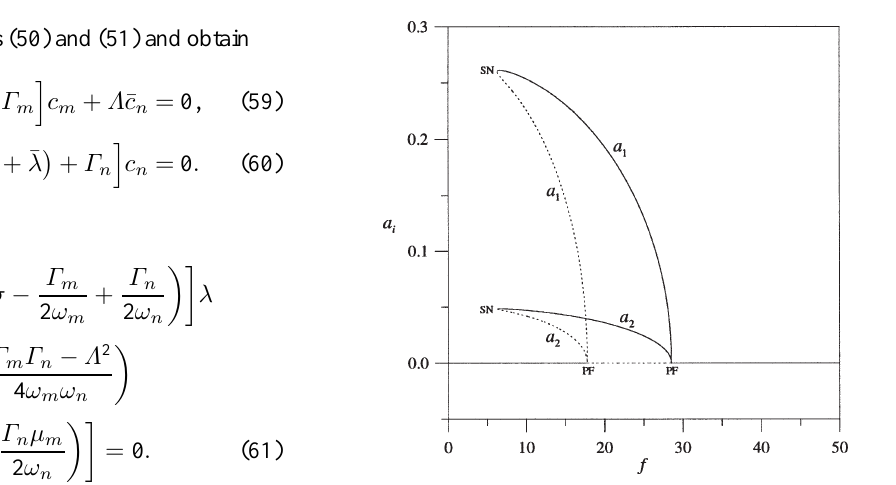
Fig. 6. Amplitude-response curves for an additive-type external sub- combination resonance involving modes 1 and 2 for (cid:27) = (cid:0)